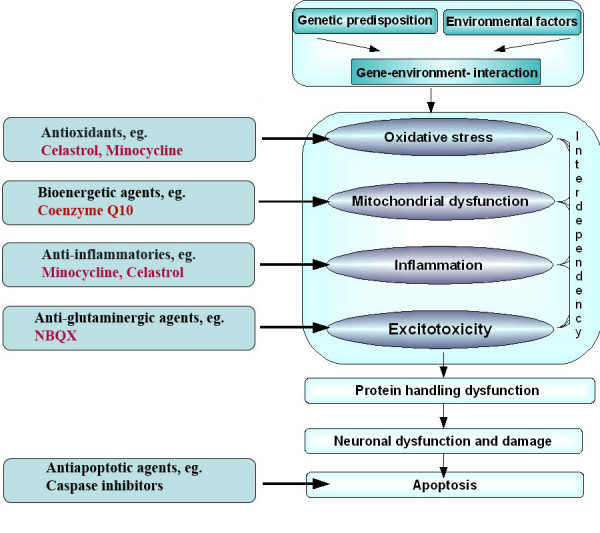
A diagram depicting possible pathogenic events in PD. A hypothetical series of molecular events likely contributing to PD pathogenesis is diagrammed. Potential sites of action by the neuroprotective agents used in this study are indicated.